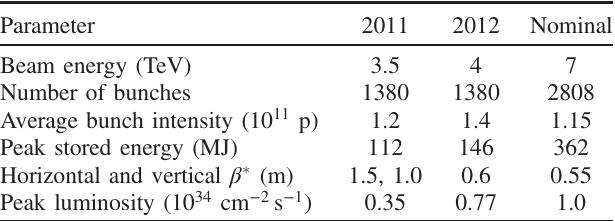
SIMULATIONS AND MEASUREMENTS OF BEAM LOSS TABLE I. Proton running conditions for physics in the LHC in 2011, 2012, and for nominal design parameters. The peak luminosity and β (cid:2) (the optical β function at the collision point) refer to the high luminosity experiments ATLAS and CMS.